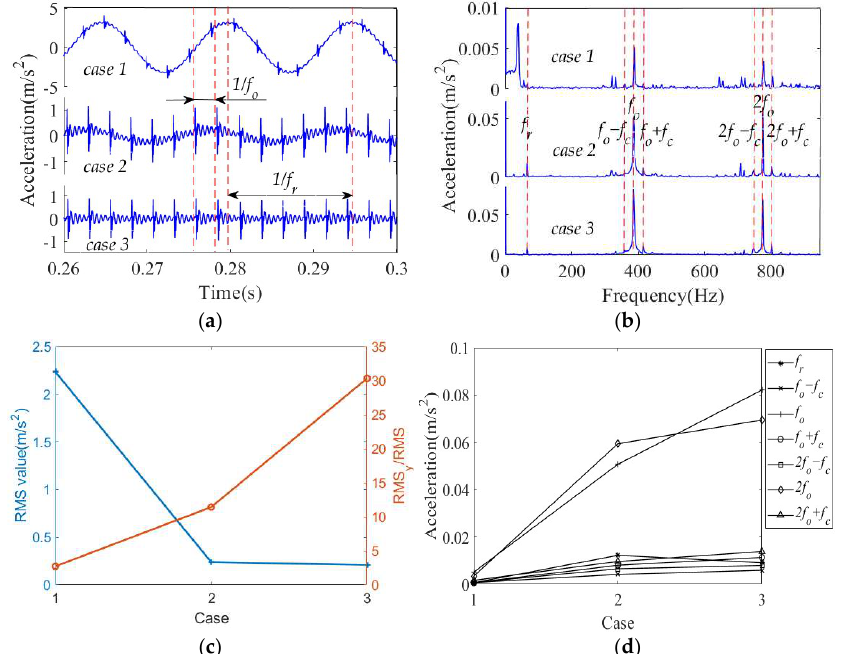
Figure 15. The time-domain and frequency responses of the bearing housing under outer ring defect and different housing stiffness: ( a ) acceleration signals; ( b ) envelope spectrum; ( c ) RMS and RMS y /RMS; ( d ) amplitudes of f r , f o − f c , f o , f o + f c , 2 f o − f c , 2 f o , 2 f o + f c .